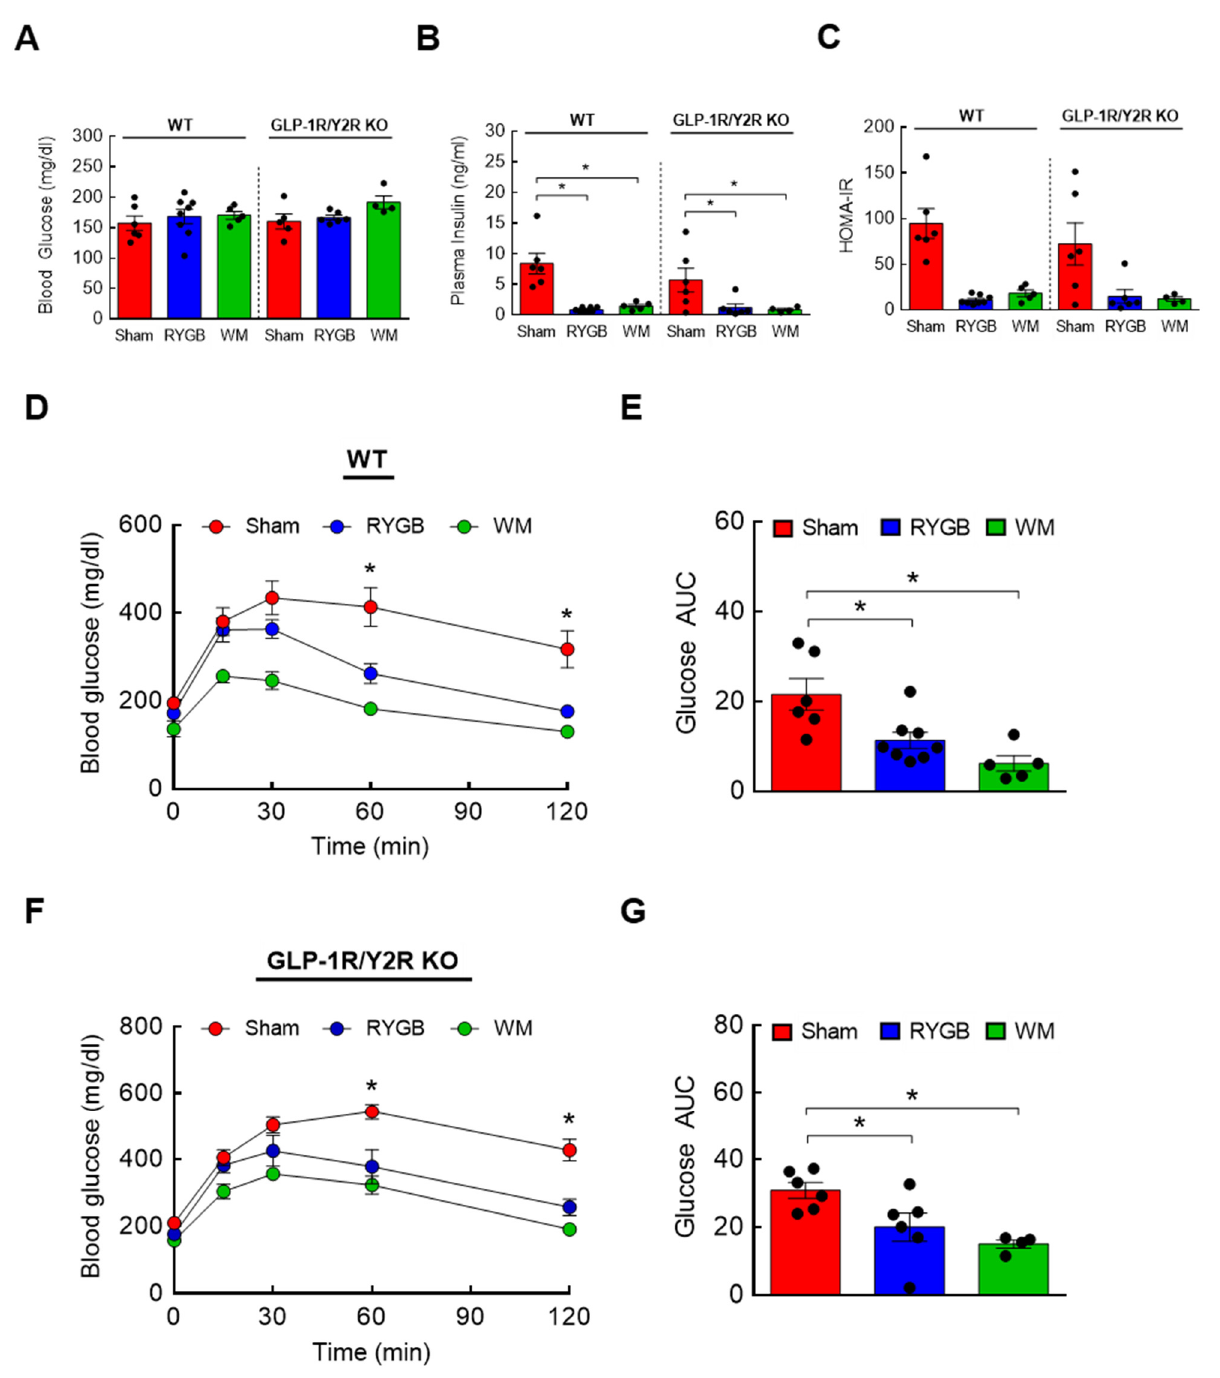
Figure 4. GLP-1/Y2R KO mice are able to improve glucose tolerance and insulin sensitivity in re- sponse to RYGB. Six-week-old male WT ( n = 5–8/group) or GLP-1R/Y2R double KO mice ( n = 4–6/group) were rendered obese on a 60% high-fat diet for 8 weeks prior to sham or RYGB surgery or caloric restriction. Trunk blood and livers were collected at sacrifice. ( A ) Blood glucose, ( B ) plasma insulin, and ( C ) HOMA-IR. Analyzed by a one-way ANOVA followed by Tukey’s post hoc test. ( D , E ) Intraperitoneal glucose tolerance test (GTT; 1.5 g/kg ip) was conducted after a 6 h fasting at 4 weeks postsurgery in WT mice and ( F , G ) in GLP-1R/Y2R KO mice. Analyzed by a two-way repeated measures ANOVA followed by a Bonferroni post hoc test. * p < 0.05.